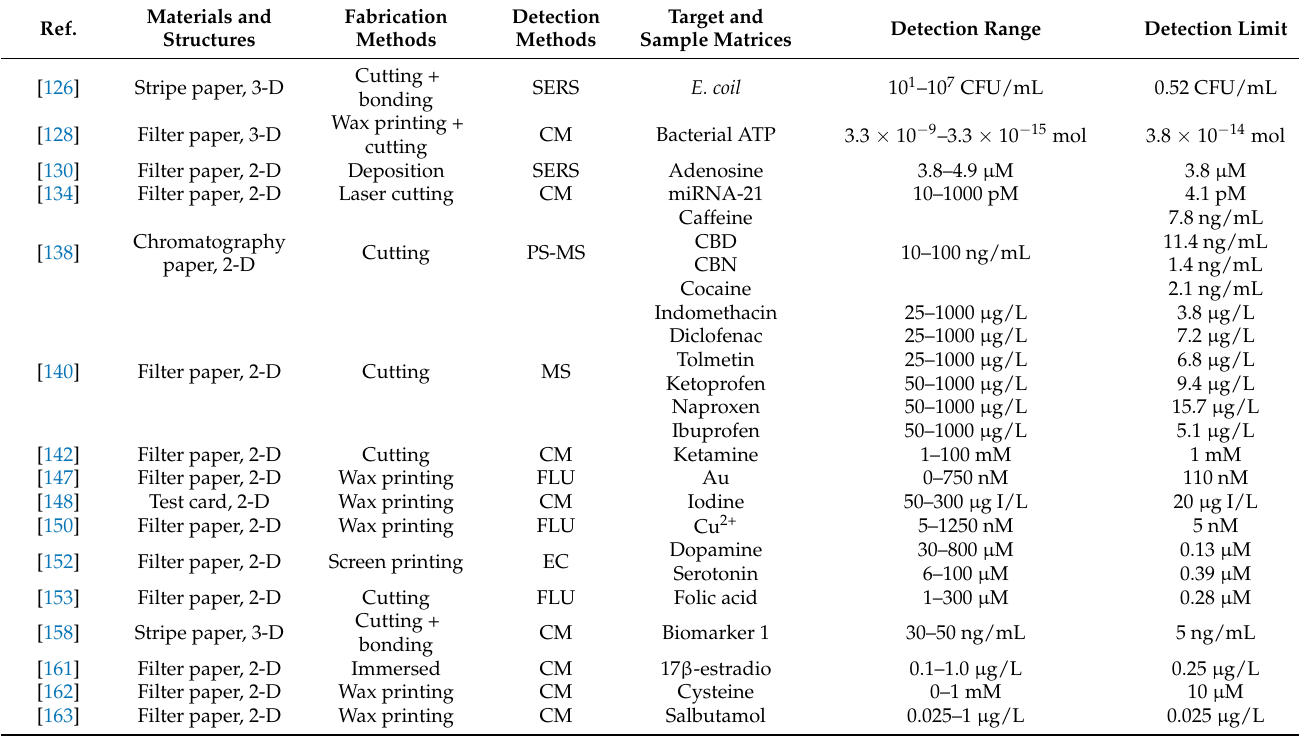
Table 3. Summarizes the µ PADs used for urine